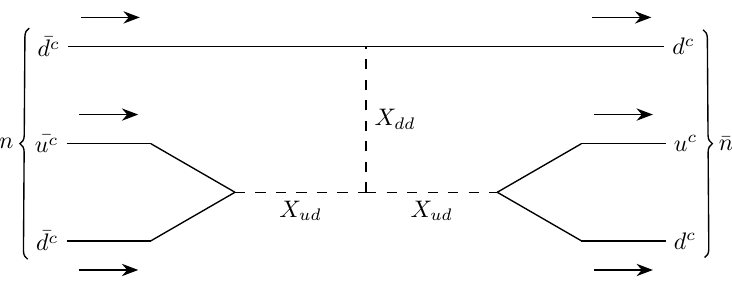
Figure 4 . Diagram for n - ¯ n oscillation with the diquark fields X dd and X ud descibed in the text.